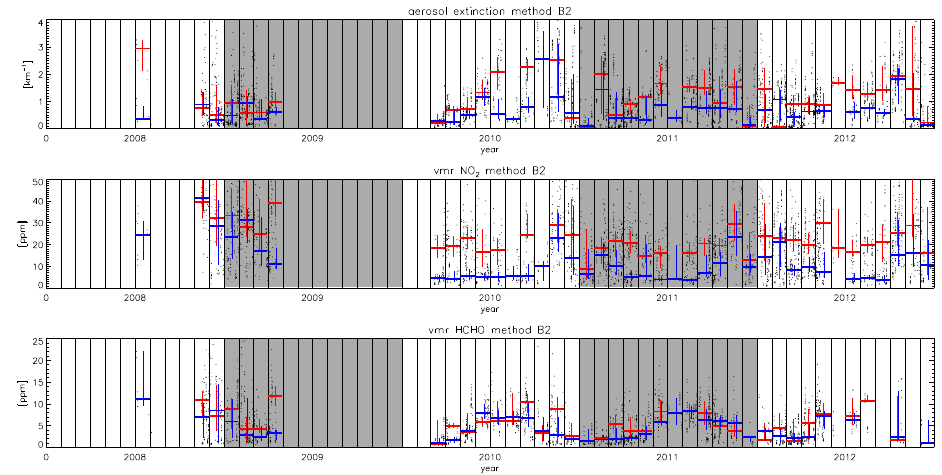
Figure 20. Time series of individual data points and monthly medians of near-surface aerosol extinction (upper row) and volume mixing ratios for NO 2 (middle row) and HCHO (bottom row), retrieved with method B. Red refers to morning observations, blue to afternoon